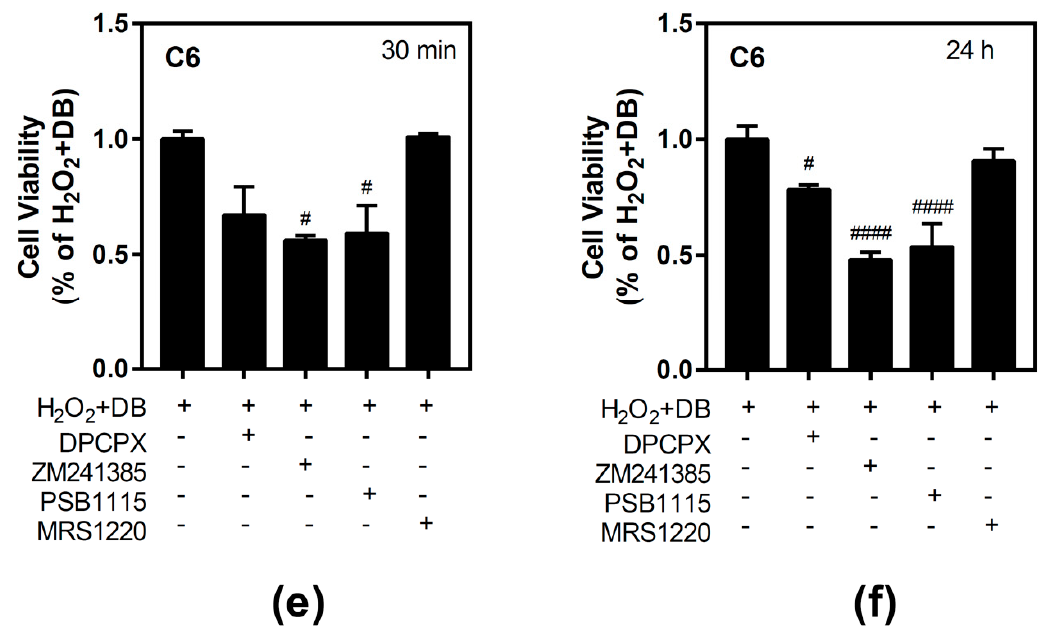
Figure 5. Effect of different beer extracts on cell viability in the presence of the oxidative stress induced by hydrogen peroxide (H 2 O 2 ) in C6 and SH-SY5Y. Treatments were performed for 30 min and 24 h with 50 µM H 2 O 2 and DB, NAB, and LB extracts in C6 (panels a and b ) and SH-SY5Y (panels c and d ) cells. Effect of 10 µM DPCPX, 100 µM ZM241385, 100 µM PSB1115, and 10 µM MRS1220, specific adenosine A 1 , A 2A , A 2B , and A 3 receptor antagonists, respectively, in the presence of 50 µM H 2 O 2 and DB (panel e and f ). Data are means ± SEM of, at least, three independent assays; # p < 0.05, ## p < 0.01, ### p < 0.001, and #### p < 0.0001, significantly different from control (C) or considered bars according to one-way ANOVA test.